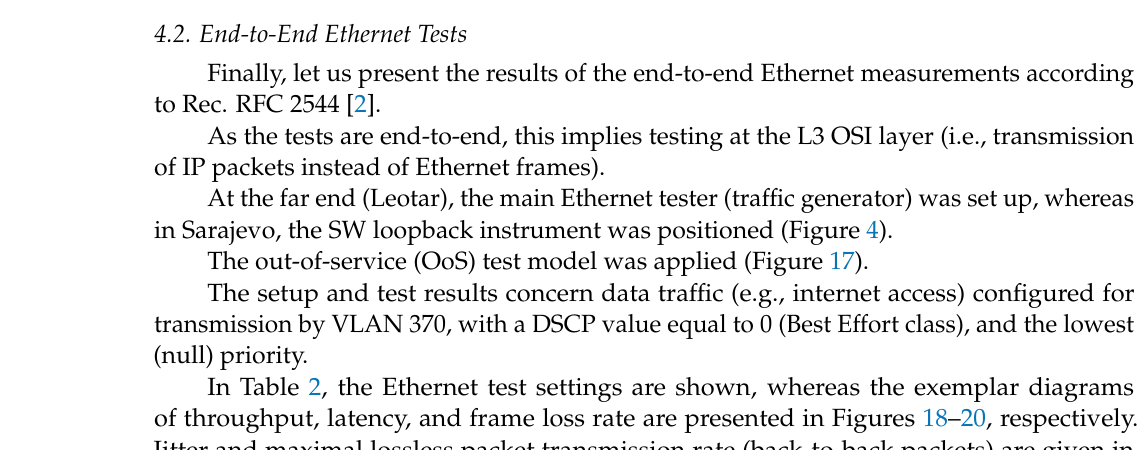
Figure 16. Prediction for the fifth RR section; 128 QAM, 323 Mb/s.